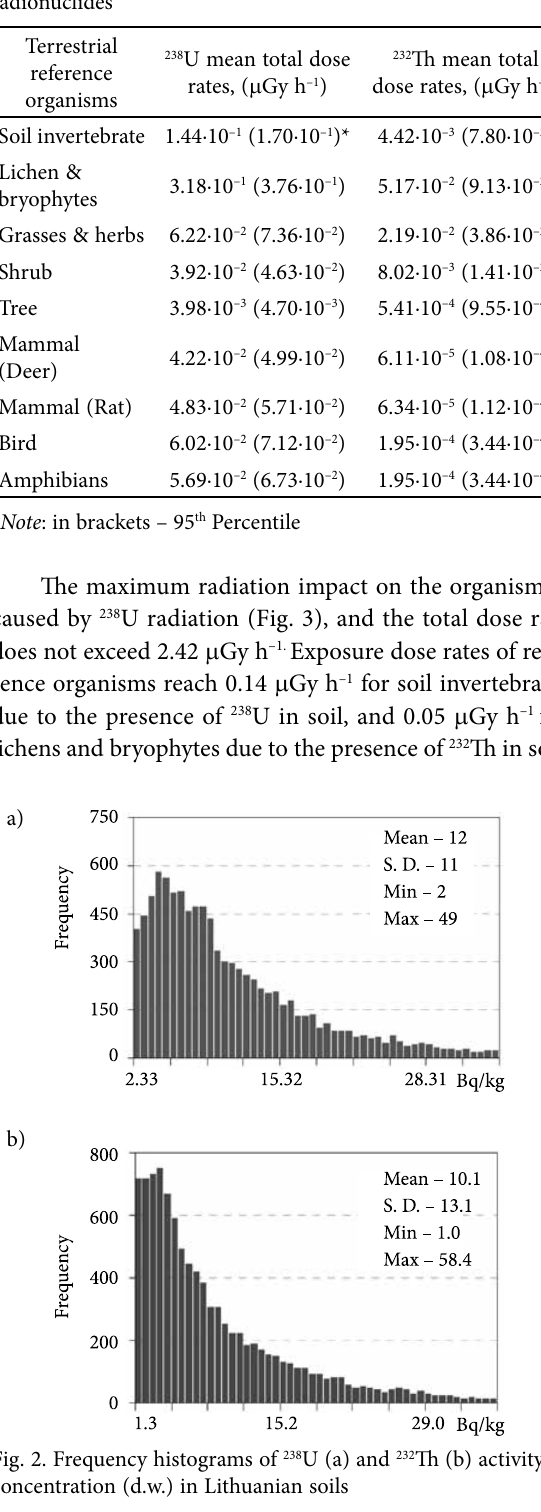
Table 1. Examples of estimated total dose rates to terrestrial reference organisms attributed to natural background